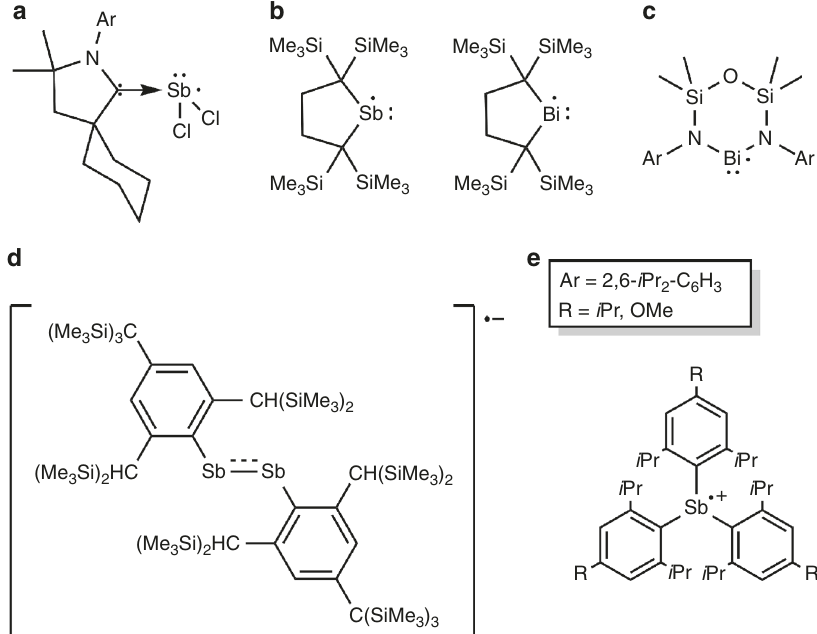
Fig. 1 Sb- and Bi-centered radicals. Persistent radicals ( a , b ), which have been identi fi ed in solution by electron paramagnetic resonance (EPR), and stable radicals of the heaviest group 15 elements ( c – e ), whose solid-state structures were determined by single-crystal X-ray diffraction